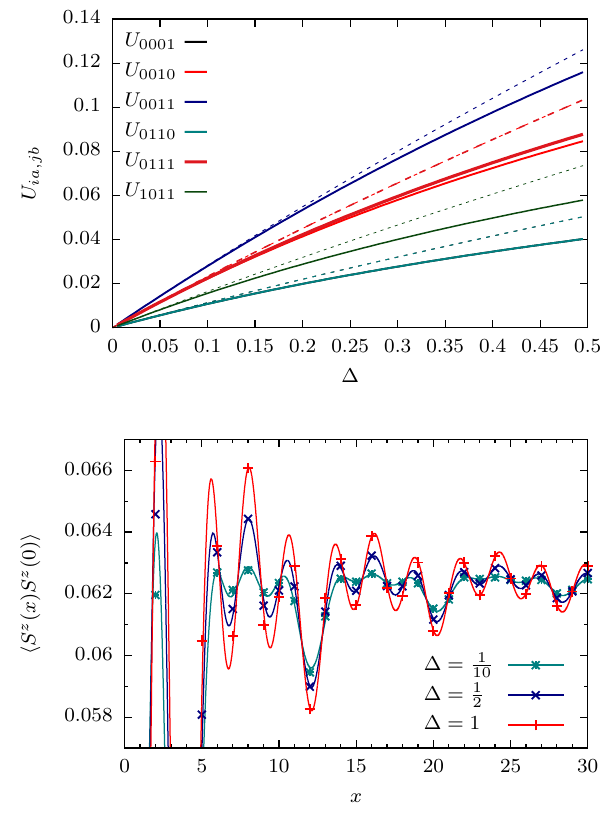
Figure 5: Non-universal prefactors (left column) and exponents (right column) as a function of anisotropy for the static real space 〈 S z ( x ) S z ( 0 ) 〉 (top row) and 〈 S − ( x ) S + ( 0 ) 〉 (bottom row) correlations of the multi-component Tomonaga-Luttinger model, computed from integrability for a state with a double Fermi sea at N = 200, M = 50 and momentum shift s = 12.